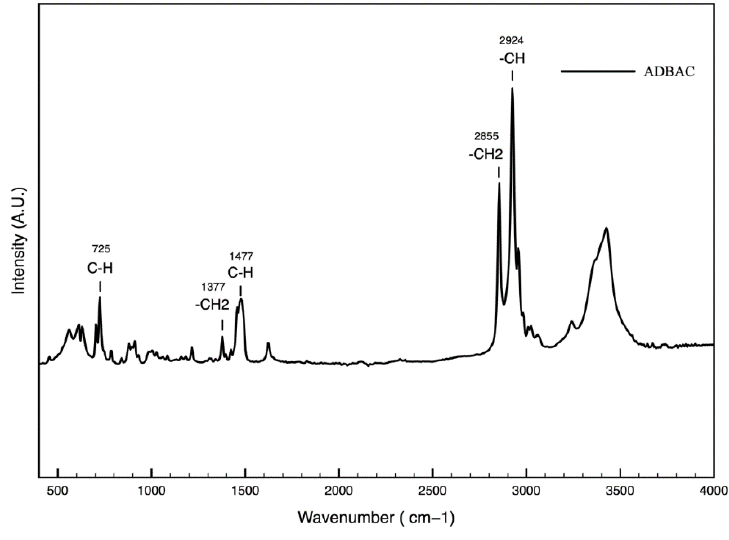
Figure A6. Diamond ATR-FTIR spectra of ADBAC in the range between 400 and 4000 cm − 1 .